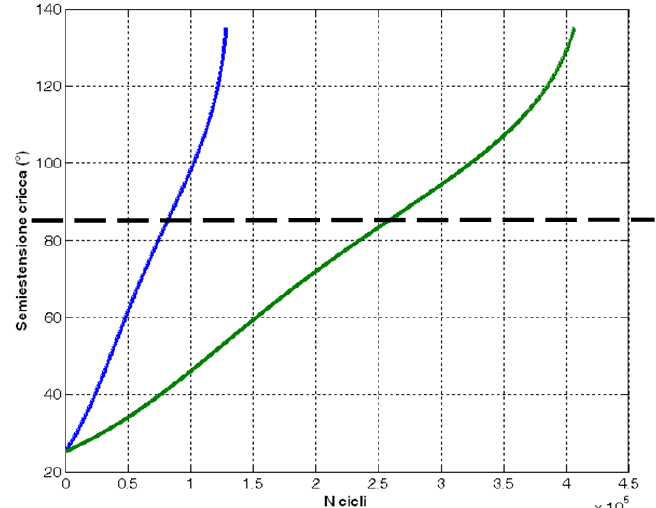
Figura 10: Semiestensione della fessura; in blu ed in verde le curve relative alla (1) e alla (2) rispettivamente .